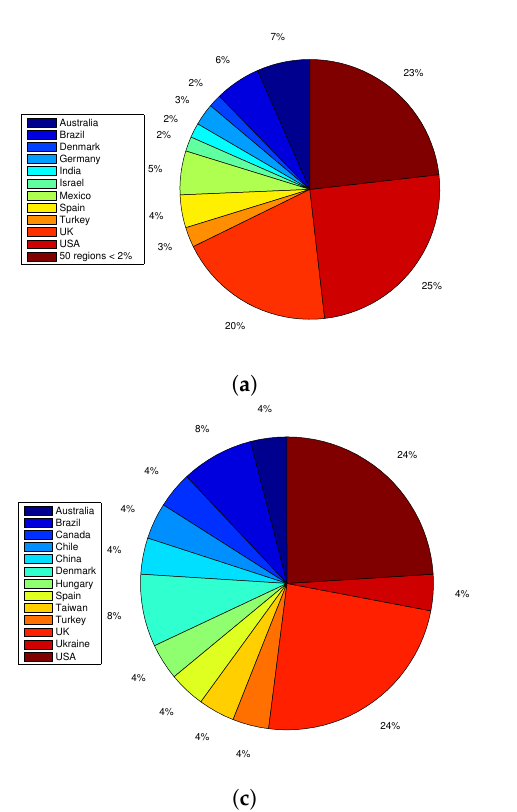
Figure 3. Percentages of the number of papers according to the geographic location declared by the authors in the corresponding affiliation of each article. We remark that the percentages are rounded off by its integer part, then apparently in ( a ) and ( d ) the total percentages are more than 100%. ( a ) Regions for authors with all types, ( b ) regions for authors with articles of notes type, ( c ) regions for authors with articles of curriculum type, ( d ) regions for authors with articles of research in classroom